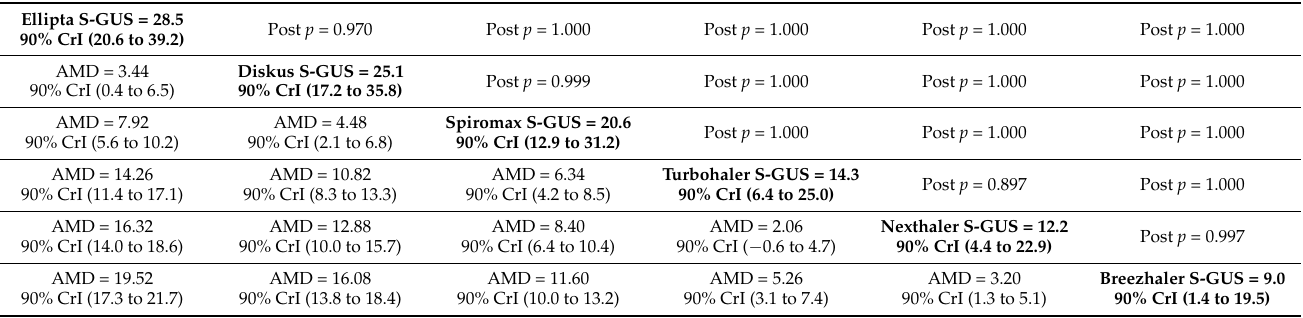
Figure 1. Evidence network based on patients in the two groups; medium thick lines represent pairwise comparisons available in Group 1 ( N = 18), thin lines represent pairwise comparisons available in Group 2 ( N = 15), and thick line represents pairwise comparison available in both groups ( N = 33). B: Breezhaler; D: Diskus; E: Ellipta; N: Nexthaler; S: Spiromax; T: Turbohaler. The GUS values estimated for each device are summarized in Table 2, ranked from the most (highest S-GUS) to the least usable (lowest S-GUS) DPI. Ellipta was the most usable device (mean S-GUS = 25.5), with a SUCRA = 99.4% (Figure 2). Diskus almost tied Ellipta (mean S-GUS = 25.1), with a SUCRA = 80.6%, and Spiromax was ranked third (mean S-GUS = 20.6), with a SUCRA = 60%. Among the least usable devices, Turbohaler was ranked fourth (mean S-GUS = 15.3), with a SUCRA = 37.9%, and Nexthaler fifth (mean S-GUS = 12.2), with a SUCRA = 22%. Finally, Breezhaler was ranked last (mean S-GUS = 9.0), with a SUCRA = 0.1%. Table 2. Results of the Bayesian analysis on the six DPIs